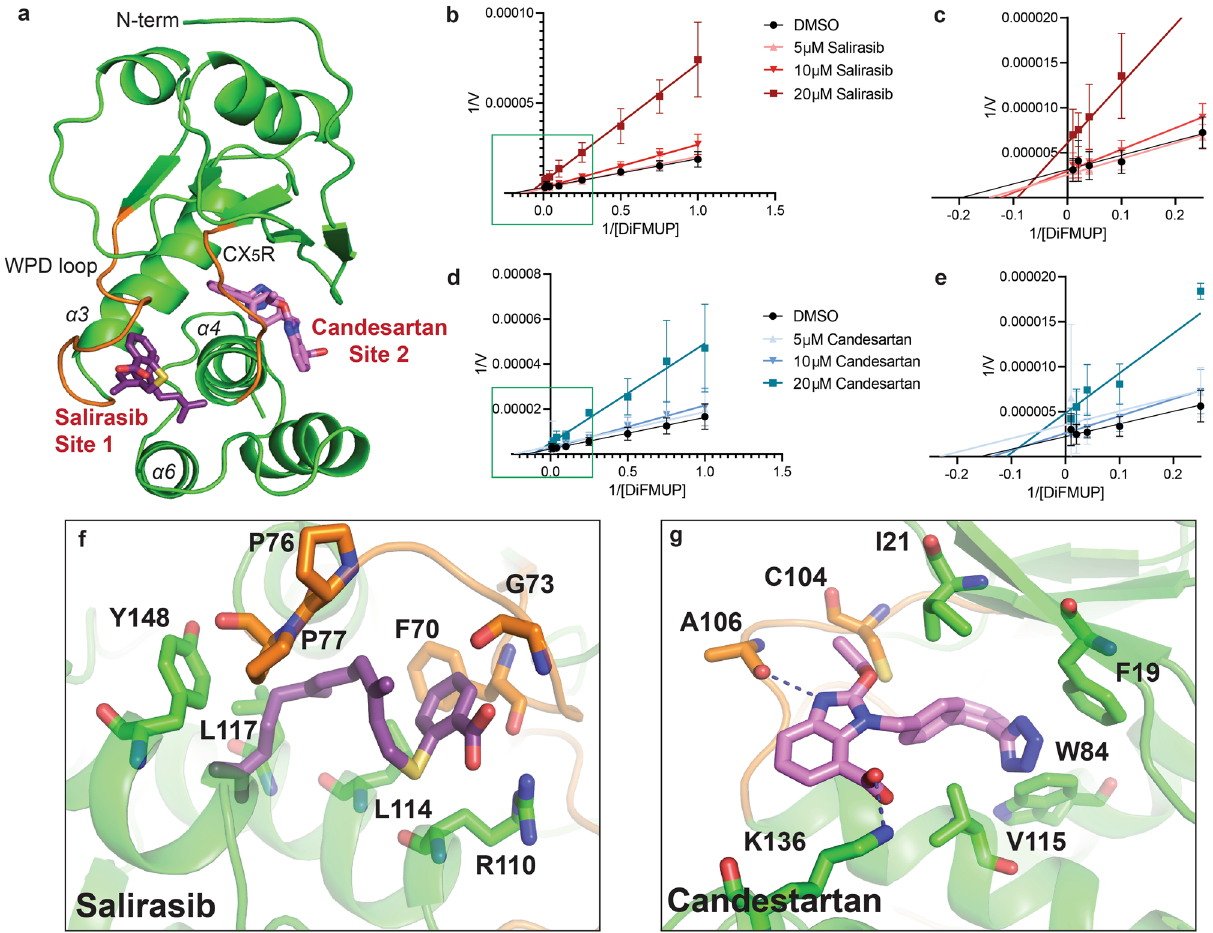
Figure 6. Molecular docking experiments reveal that top hits from screening FDA-approved drugs bind to allosteric sites. ( a ) Representive compounds, Salirasib and Candesartan, are shown bound to two identified allosteric sites adjacent to the active site looops (orange) in the closed conformation of PRL-3 (PDB: 2MBC). Lineweaver–burk plots indicate that Salirasib ( b , c ) and Candesartan ( d , e ) are non-competitive inhibitors to the substrate, supporting the docking results. Graphs in ( c ) and ( e ) are insets of the boxed areas in ( b ) and ( d ). Assays were run with technical duplicates and performed in 3 independent replicates. Error bars represent standard deviation between assays. Proposed binding modes of Salirasib ( f ) and Candesartan ( g ) on PRL-3, with residues in close proximity to the bound molecule